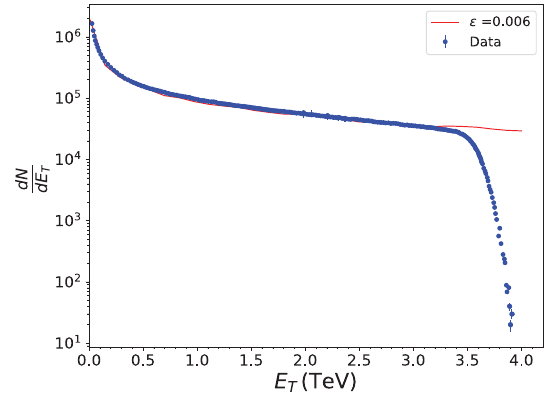
Figure 6. The fit of equation 1 with (cid:4) = 0 . 006 TeV to the data in figure 1.